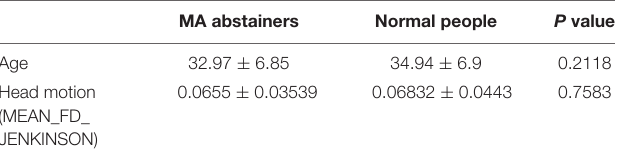
TABLE 1 | Head movements and age information of the